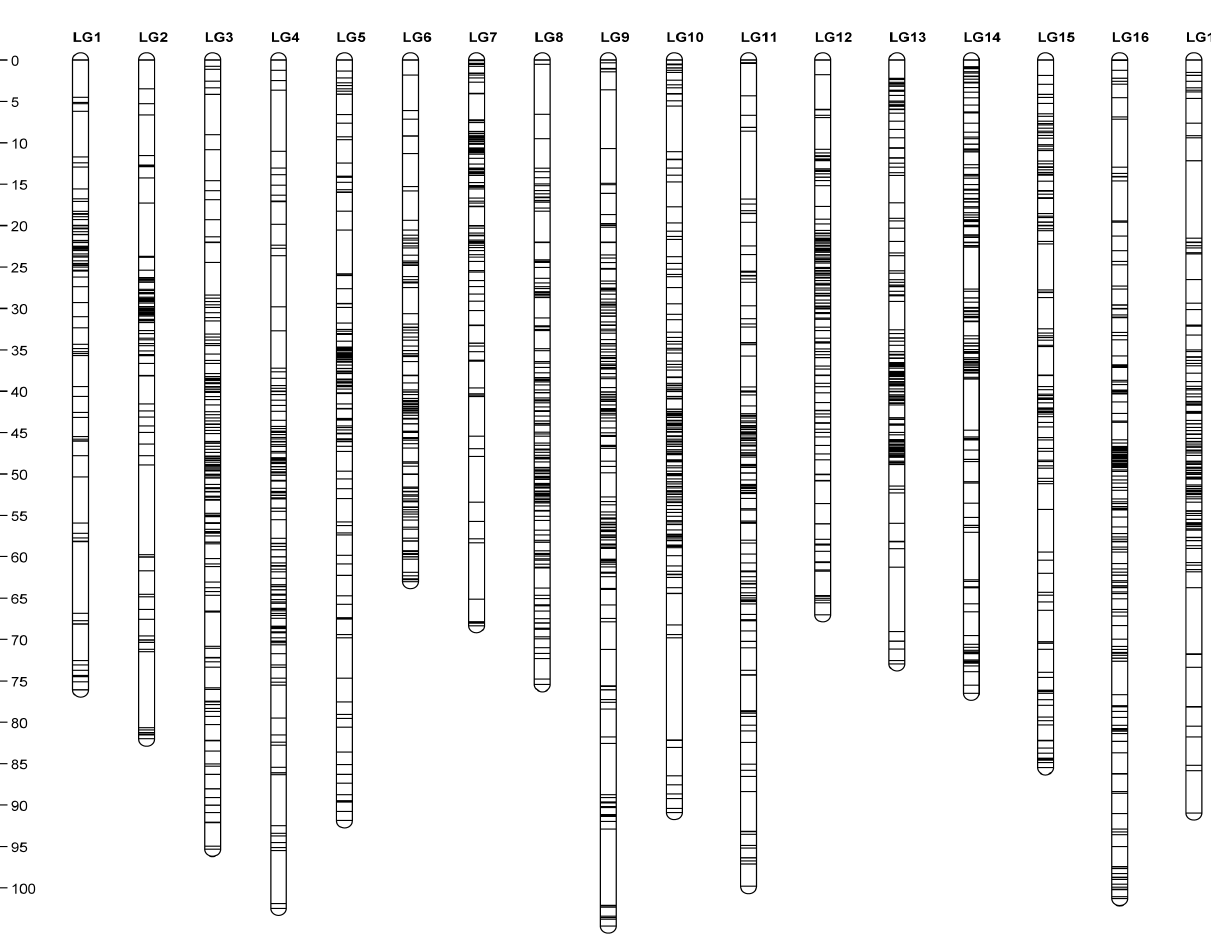
Figure 2. Schematic representation of the consensus map. Ruler on left indicates the cM distance and the horizontal lines across the chromosomes indicate locus positions on each chromosome.